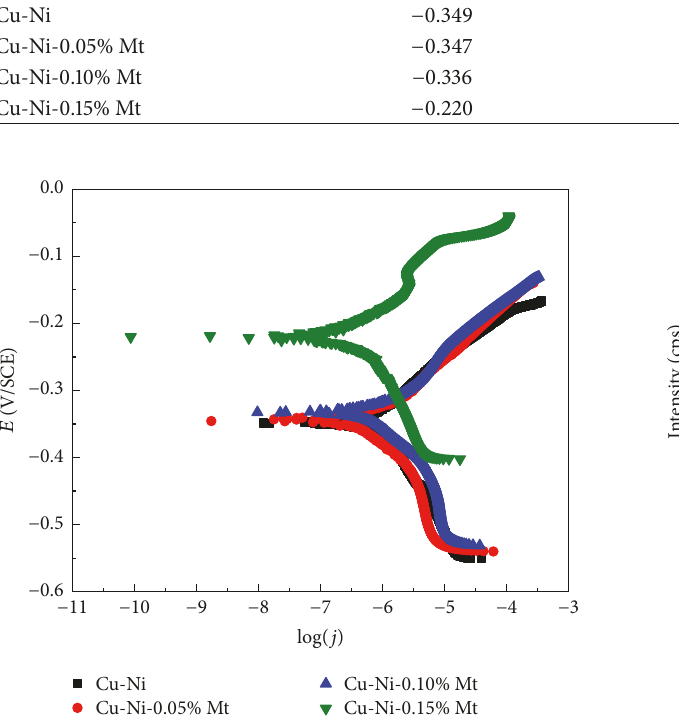
Figure 8: X-ray diffraction scans of the 90-10 Cu-Ni and Cu-Ni- 0.15%Mtcoatingsaftersoakinginthesimulatedseawaterfor30days to determine the corrosion products (ss: steel